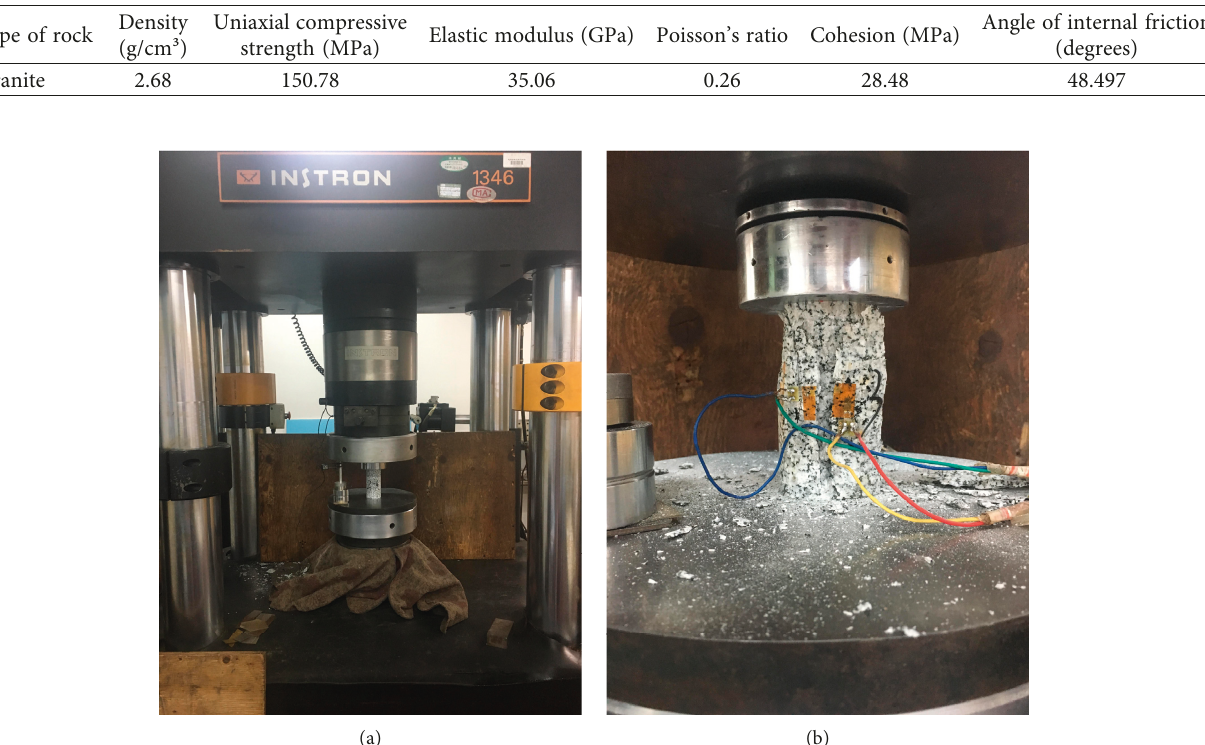
Table 1: Physical and mechanical parameters of granite.